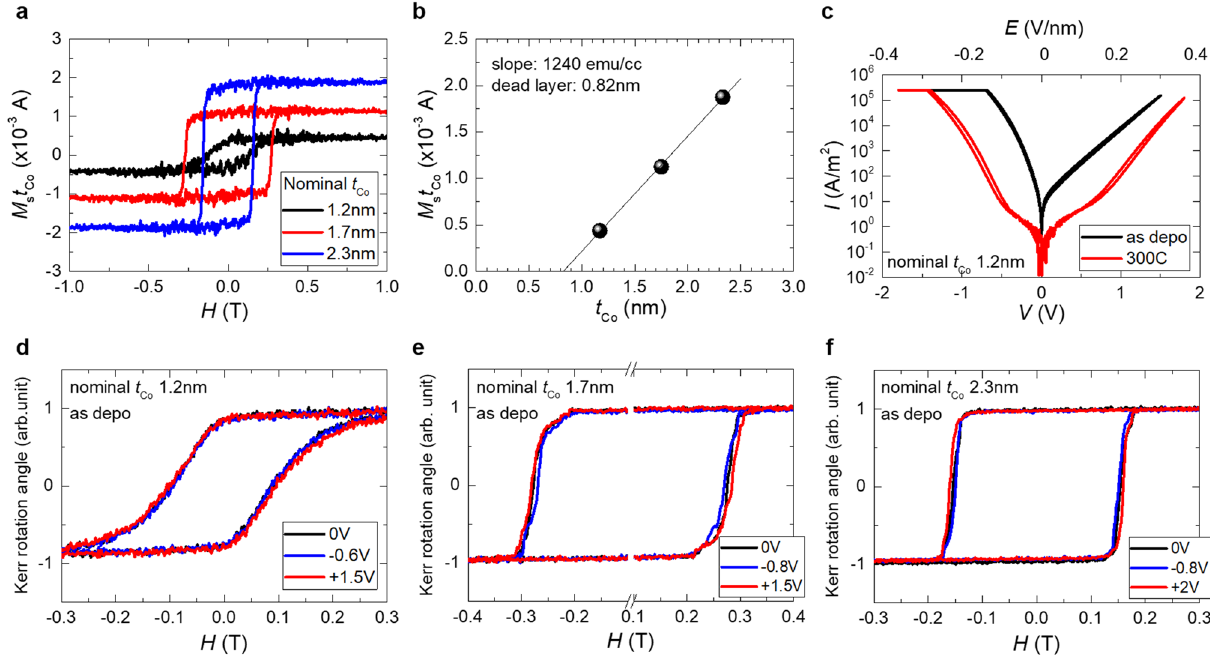
Figure 2. ( a ) Perpendicular magnetization curves of nominal SiO x sub./Ta (5 nm)/Ru (10 nm)/Ta (5 nm)/ Pt (10 nm)/Co (1.2, 1.7, and 2.3 nm)/TiO x (3.8 or 5 nm)/Pt (5 nm)/Ru (2 nm) samples measured by VSM. ( b ) Co thickness dependence of the M s t Co of the samples. ( c ) I–V characteristics of the as-deposited and 300 °C annealed sample with nominal Co thickness 1.2 nm. ( d )–( f ) Bias-voltage-dependence of the perpendicular magnetization curves of the samples with nominal Co thickness ( d ) 1.2 nm, ( e ) 1.7 nm, and ( f ) 2.3 nm, measured by